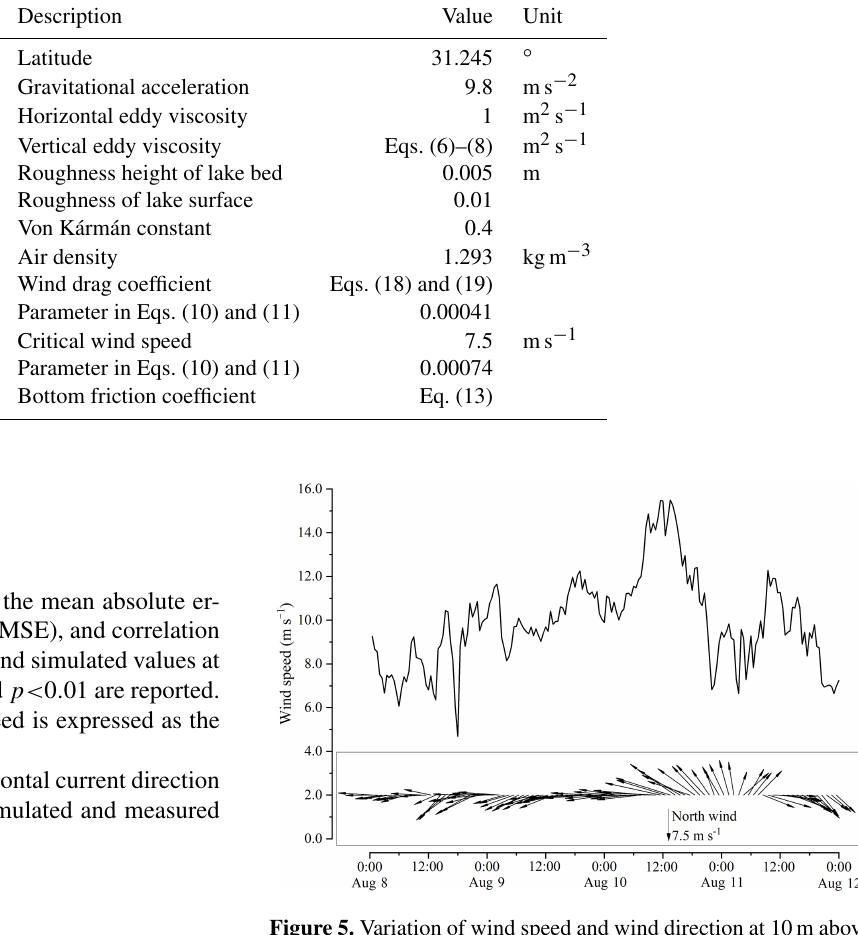
Figure 5. Variation of wind speed and wind direction at 10m above the water surface at the LHWS during the 2015 summer observa-